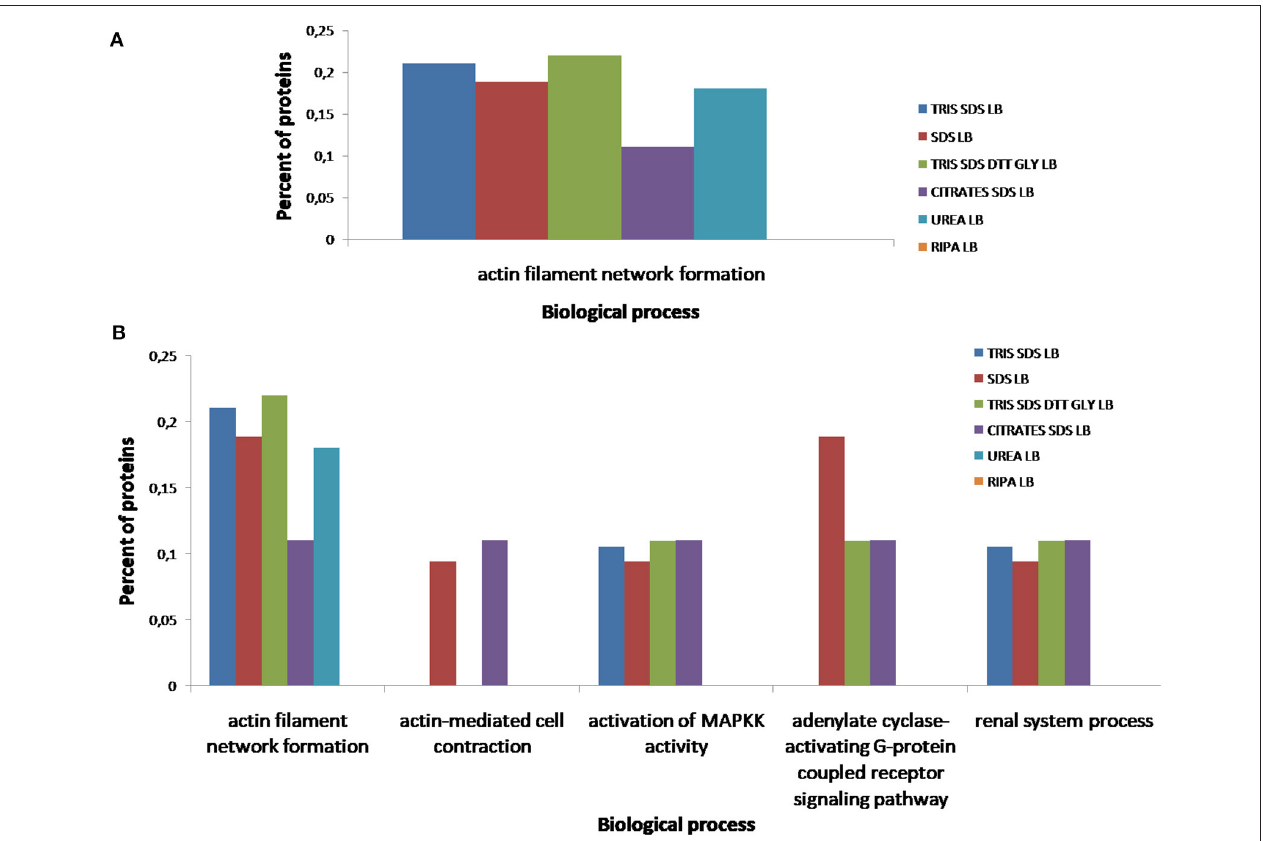
FIGURE 11 | Functional classification of all proteins identified after the extraction with the six different buffers [ buffer 1 (Tris-SDS LB), n = 979 proteins; buffer 2 (urea LB), n = 569 proteins; buffer 3 (Tris-SDS-DTT-Glycerol LB), n = 930 proteins; buffer 4 (citrate-SDS LB), n = 921 proteins; buffer 5 (SDS-LB), n = 1,086 proteins; buffer 6 (RIPA LB), n = 540 proteins], according to their biological process: (A) actin filament network formation, (B) actin-mediated cell contraction, activation of MAPKK activity, adenylate cyclase-activating G-protein coupled receptor signaling pathway, renal system process, using the FunRich program.